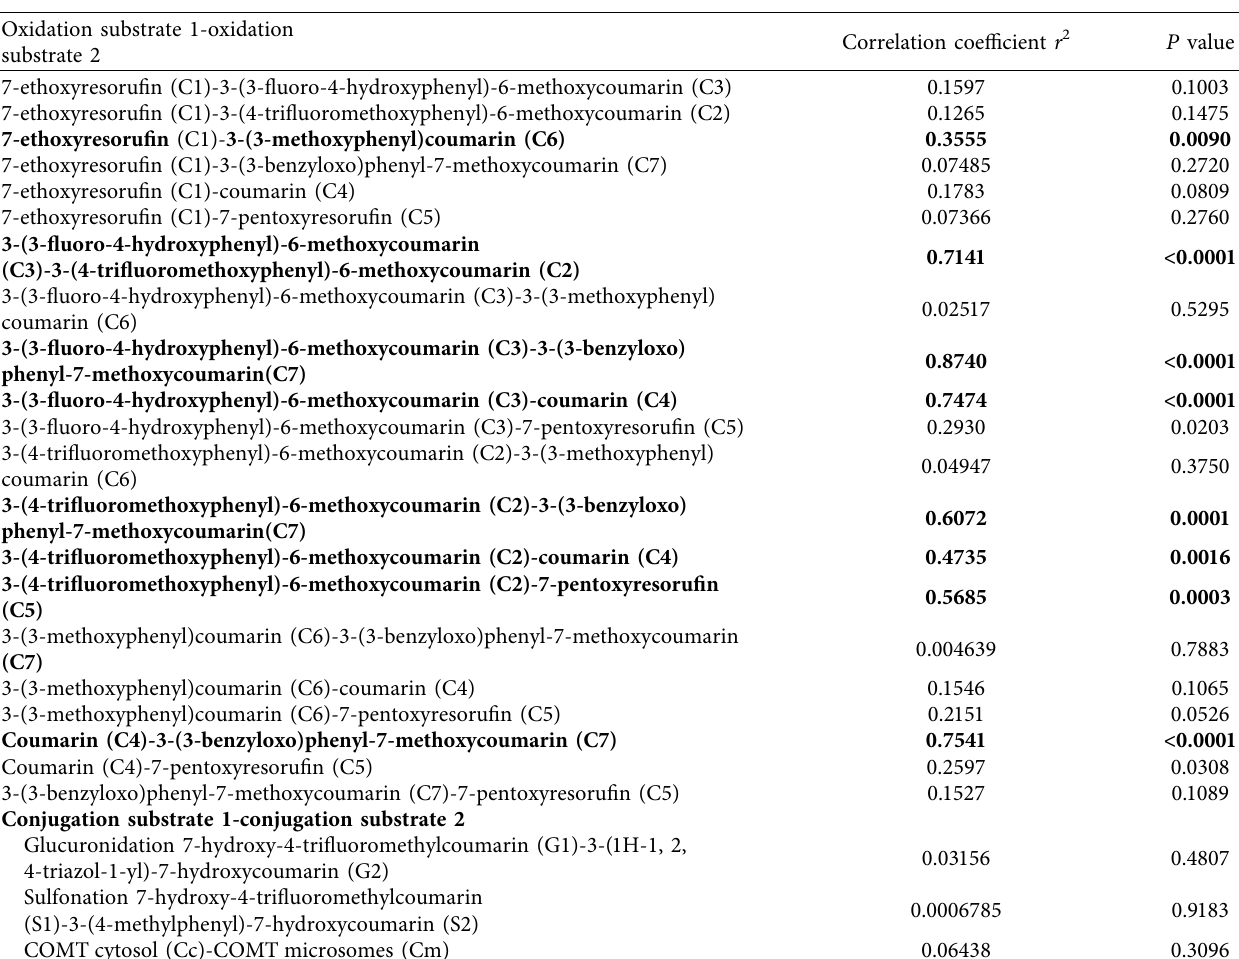
Values in bold indicate a statistically signifcant correlation. Letter number abbreviations, e.g., C1 in the brackets after the substrate point to the reactions of Figure 4.